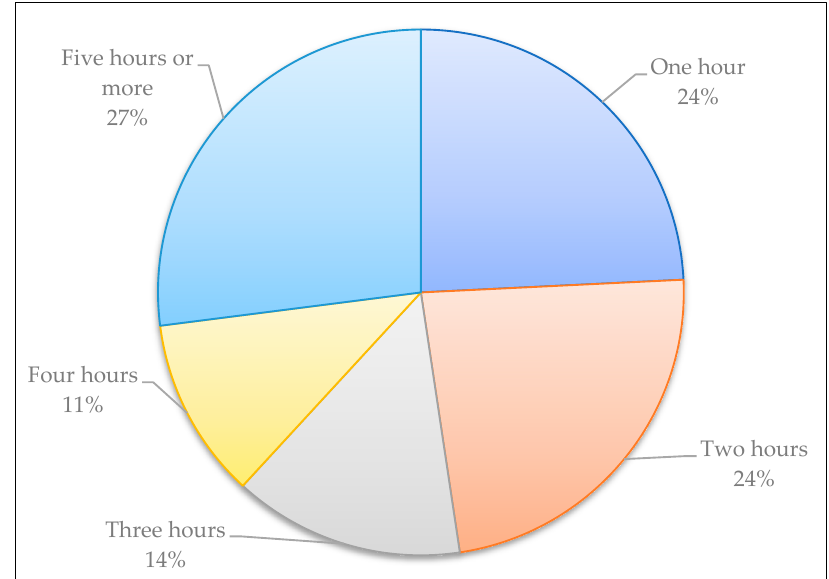
Figure 9. Number of hours spending outside home exclusive of working time.